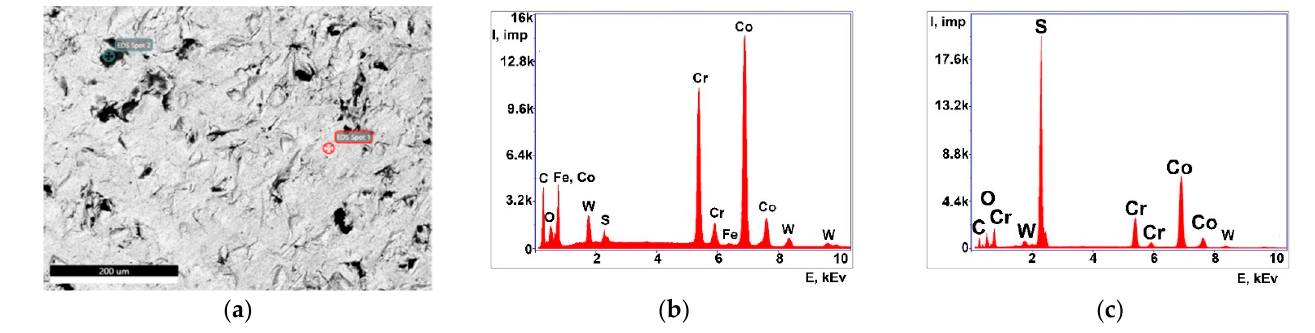
Figure 4. SEM images of the abutment surface: ( a ) General view; ( b ) ED spectrum from the light area; ( c ) ED spectrum from the dark area. Table 3. Quantitative composition of one of the light areas. Element Weight